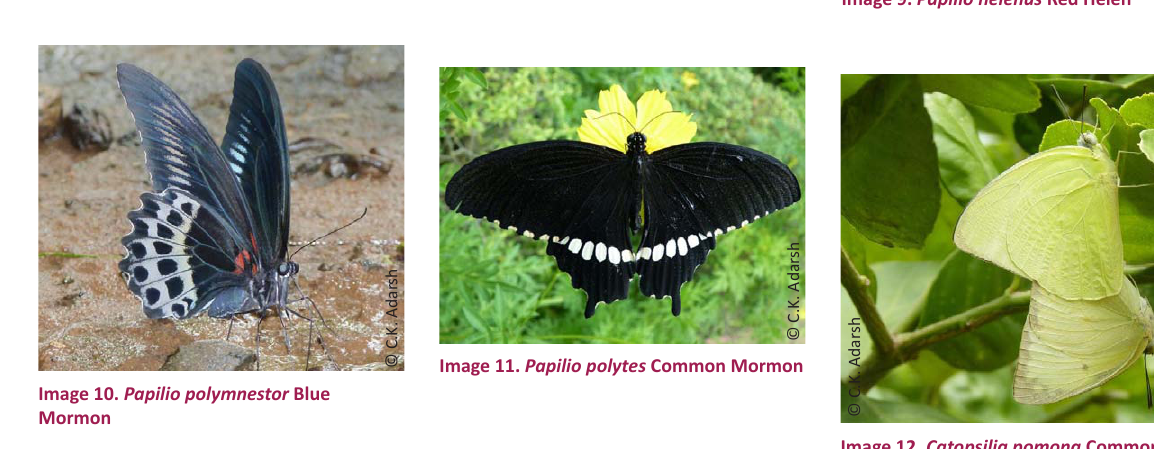
Image 9. Papilio helenus Red